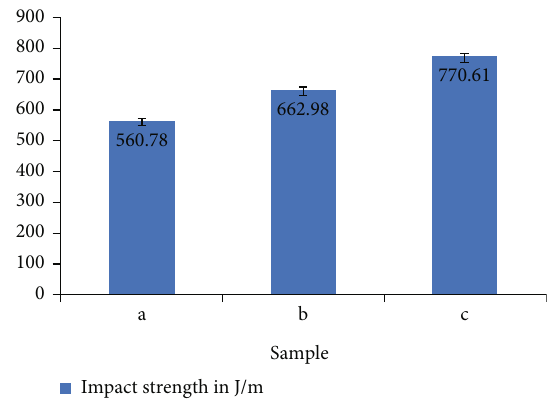
Figure 6: Impact strength of epoxy hybrid